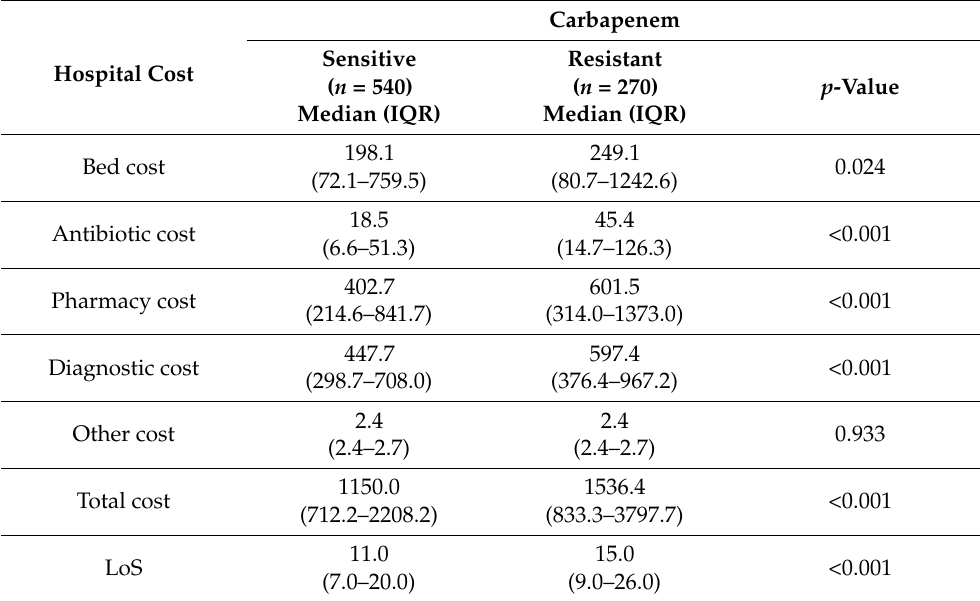
Table 3. Comparison length of stay and various kind of costs between carbapenem-sensitive and resistant cases (in 2021 US$).